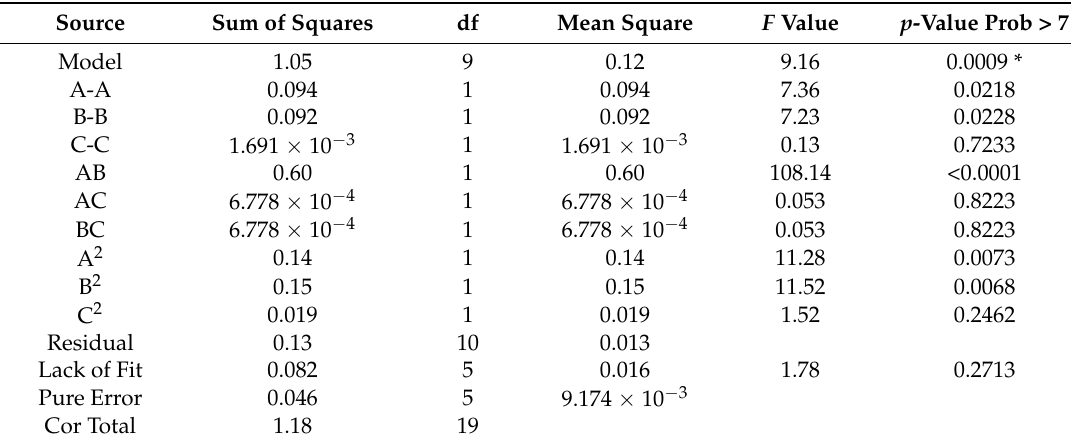
Table 3. Statistical analysis of variance for the experimental